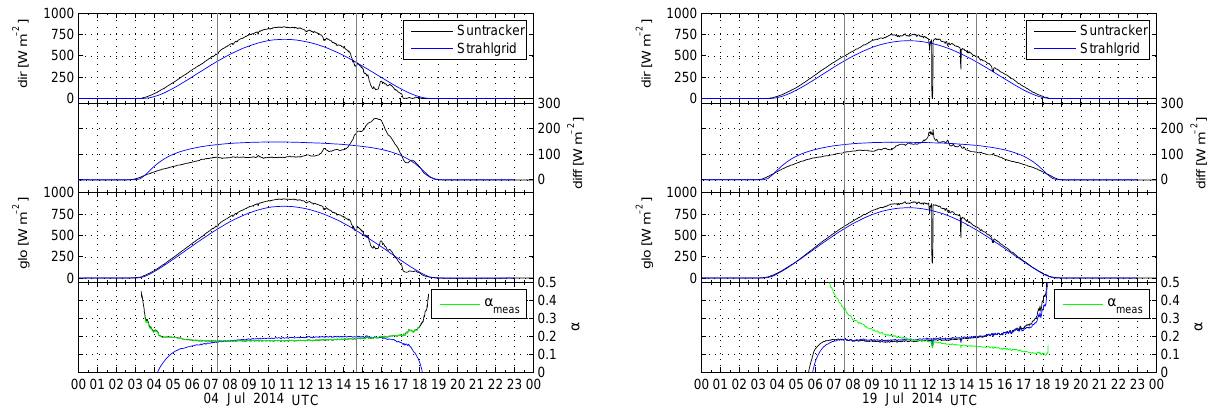
Figure 8. Comparison of the radiation data of the Suntracker and the STRAHLGRID model for the 2 example days at the roof of ZAMG for a horizontally levelled (left) and an inclined pyranometer (right), including the difference of the corrected albedo.